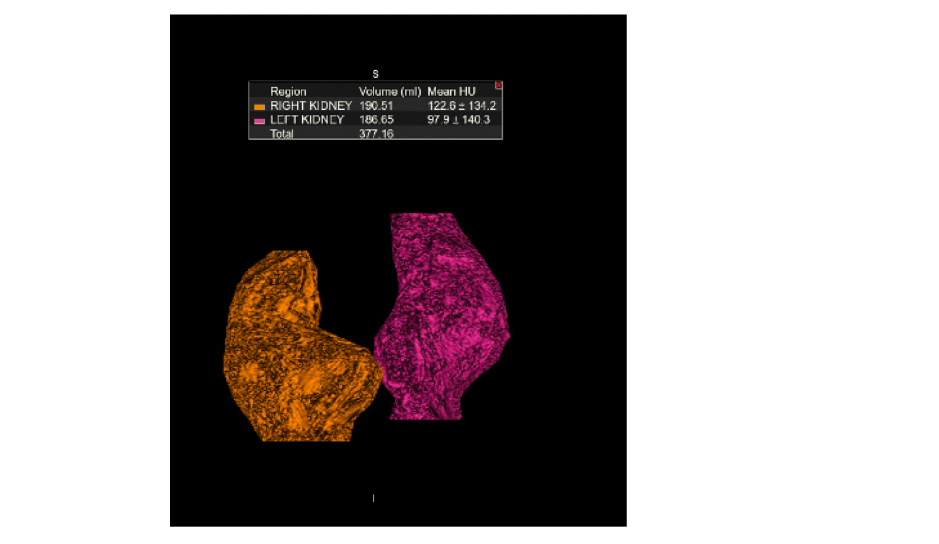
Figure 3. Volumetric CT reconstruction of the kidneys measuring 190.51 mL for the right kidney and 186.65 mL for the left kidney.